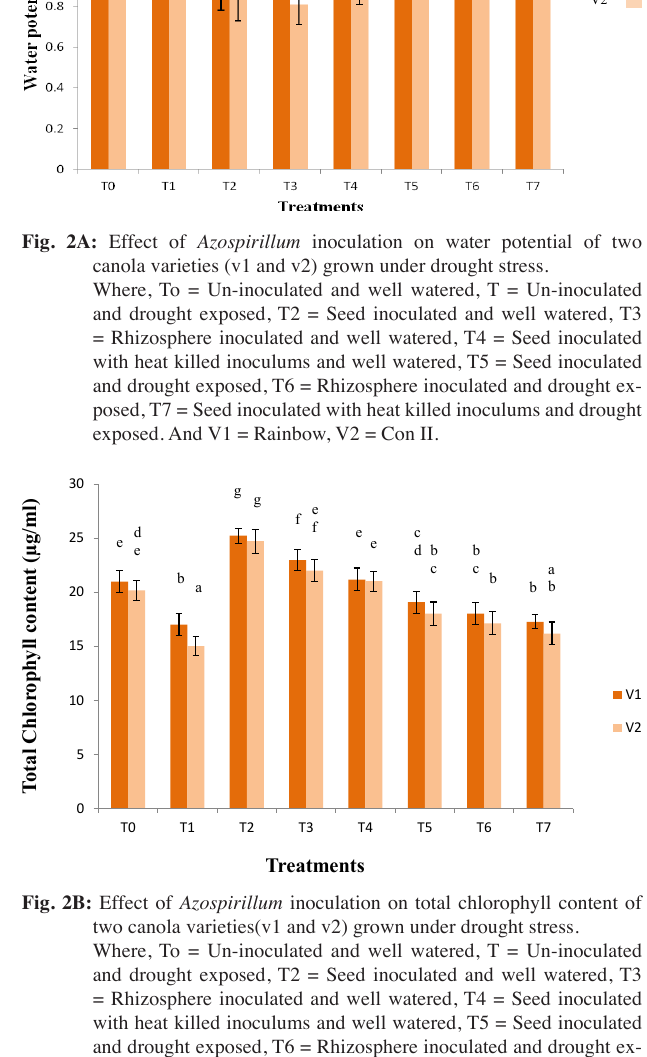
Fig. 1D: Effect of Azospirillum inoculation on root surface area of two canola varieties (v1 and v2) grown under drought stress. Where, To = Un-inoculated and well watered, T = Un-inoculated and drought exposed, T2 = Seed inoculated and well watered, T3 = Rhizosphere inoculated and well watered, T4 = Seed inoculated with heat killed inoculums and well watered, T5 = Seed inoculated and drought exposed, T6 = Rhizosphere inoculated and drought ex- posed, T7 = Seed inoculated with heat killed inoculums and drought exposed. And V1 = Rainbow, V2 = Con II.